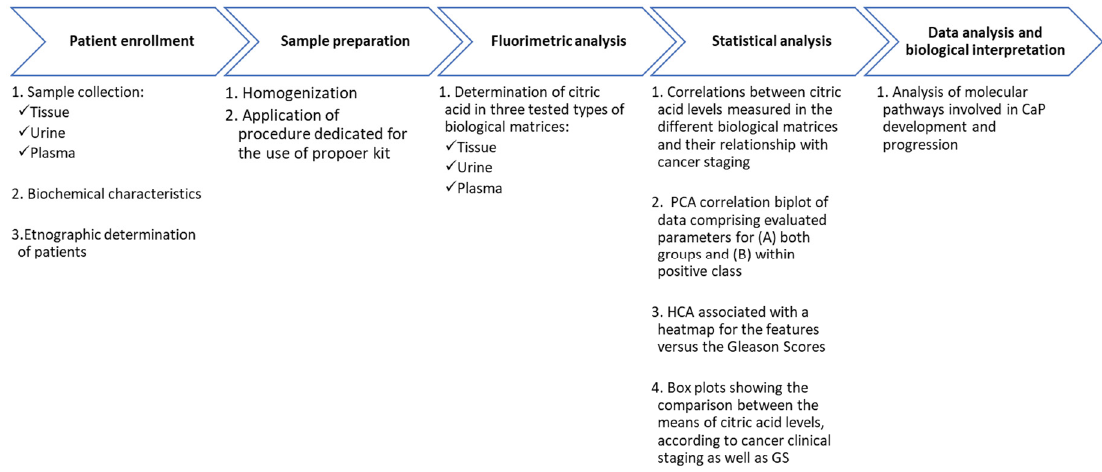
Figure 8. Schematic view of the workflow with special emphasis on the used